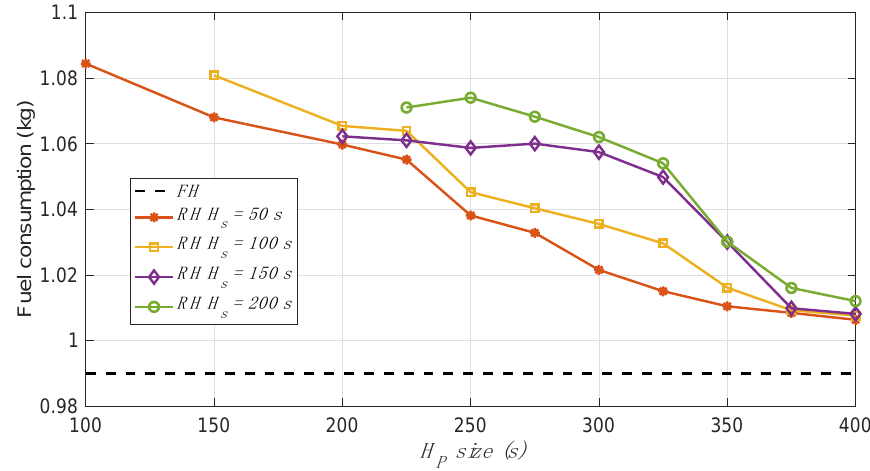
Table 1. Fuel consumption results achieved with RH-based EMS compared with the FH approach with different H s and H p .